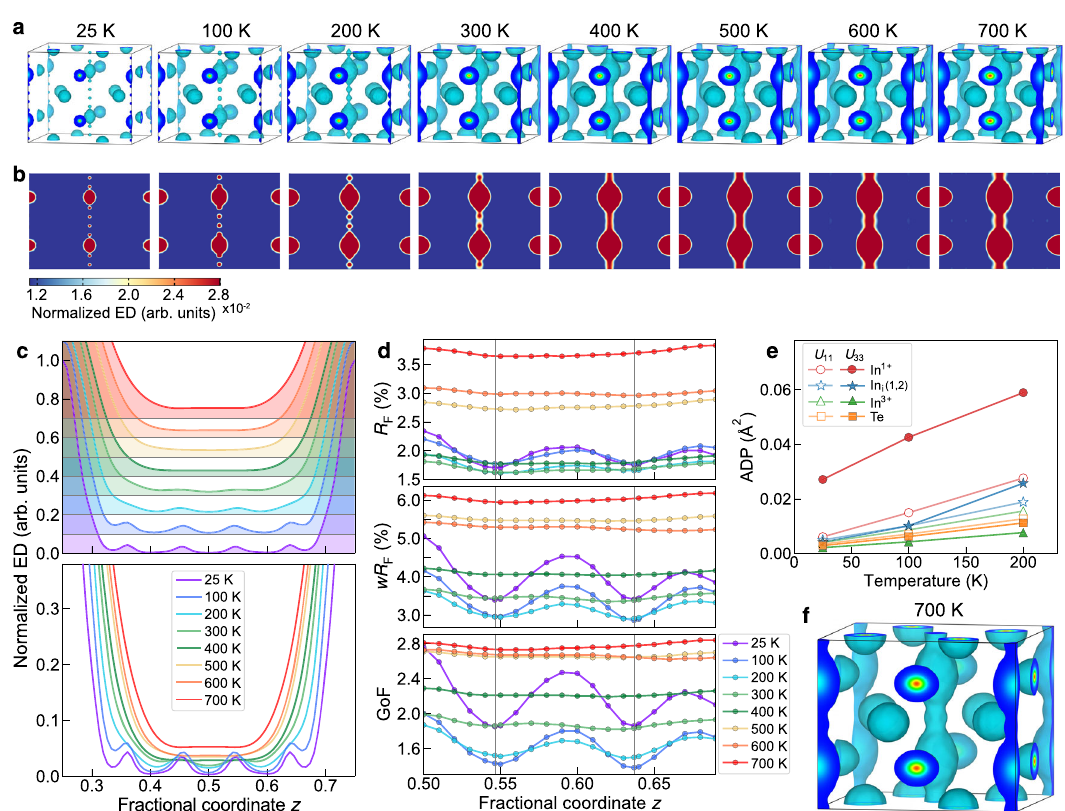
Fig. 3 Temperature-driven 1D diffusive, disordered In 1 + channel in InTe. a 3D MEM electron density maps at 25-700 K. The isosurface values are set at 1.45% and 2.35% of the peak electron density values of the In 1 + sites for the 25-600 K and 700 K MEM maps, respectively. b 2D MEM electron density maps at 25-700 K on the (100) plane at x = 0.5. The 2D MEM density maps at 25-600K and 700 K are normalized, respectively, with one times and 1.58 times of the maximum values at the In 1 + sites. The ED denotes the electron density. c 1D MEM electron density pro fi le through the In 1 + ions along the [001] direction at 25 – 700 K. The EDs at different temperatures are normalized for better comparison. d The R F , wR F , and GoF values for the constrained structure re fi nements with one interstitial indium moving along the c axis between In 1 + sites. Two light gray vertical lines represent the locations of the two interstitial indium sites. e Anisotropic atomic displacement parameters (ADPs) of InTe re fi ned with the two interstitial model. f Enlarged 3D MEM electron density map of InTe at 700 K with an isosurface value of 1.01 e Å -3